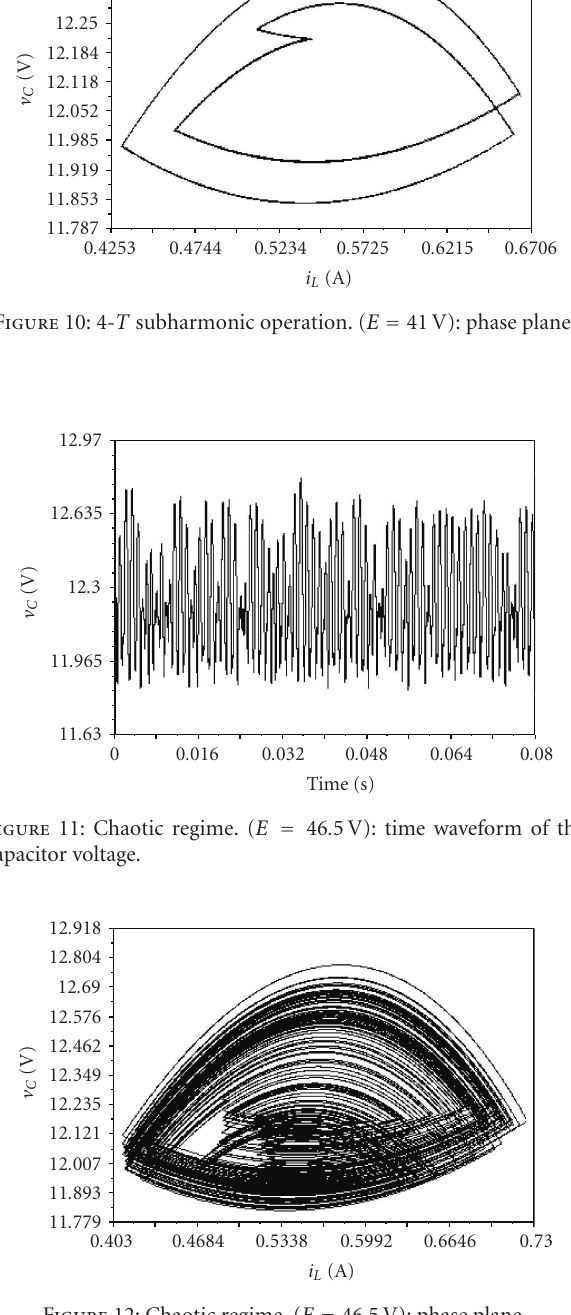
Figure 12: Chaotic regime. ( E = 46 . 5 V): phase